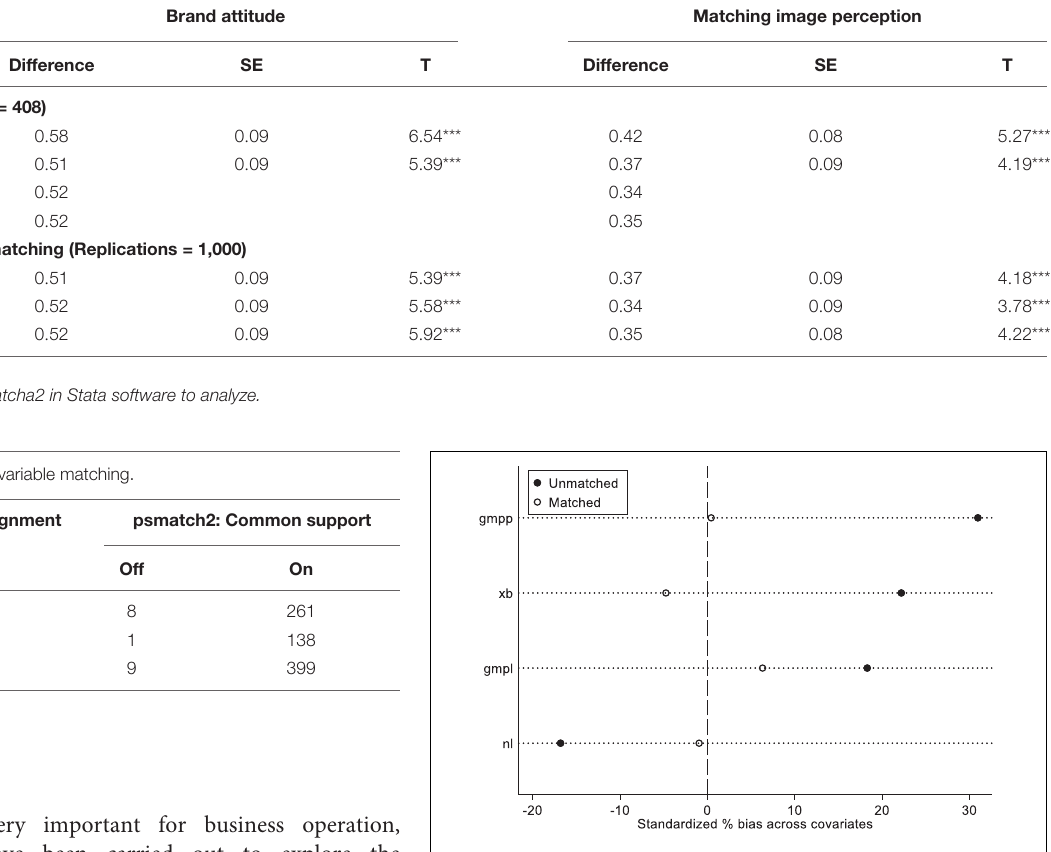
FIGURE 2 | Comparison of covariate bias before and after